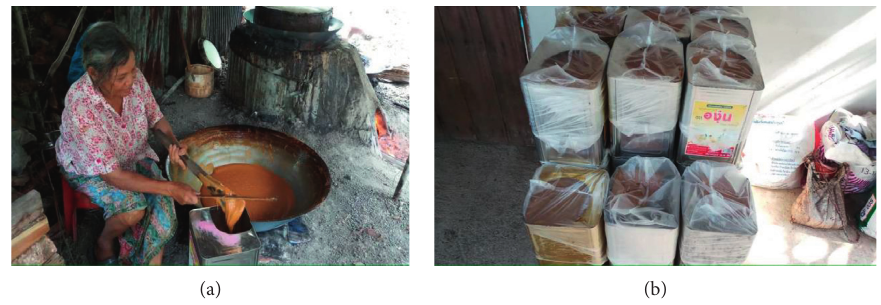
Figure 7: Farmer and molasses production.